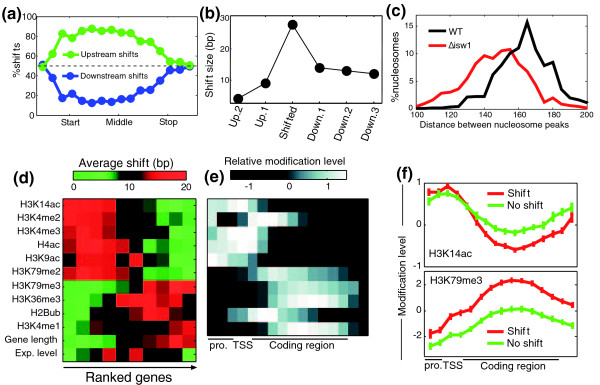
Patterns of Isw1-dependent shifts. (a) Percentage of Isw1-shifts that are upstream (green; nucleosomes are moved towards the 5' end in Δisw1) and those that are downstream (blue; nucleosomes are moved towards the 3' end in Δisw1) as a function of the relative position within genes (with respect to the start and stop codons). (b) Asymmetric effects at nucleosomes adjacent to those with shifts. For each gene with Isw1-shifts above 15 bp, we examined the extent of upstream shifts at the maximally shifted nucleosome and at its upstream and downstream adjacent nucleosomes, and the average shift sizes are shown. (c) Distribution of estimated distances between nucleosome centers of mid-coding nucleosomes (that are shifted upstream in Δisw1) and their flanking upstream nucleosomes, for wild-type (WT) and Δisw1 strains. (d) Average sizes of Isw1 upstream shifts at the +5 nucleosome for 10 subsets of genes ordered by various histone modifications, gene length, or mRNA expression levels. H3K79me2/3 and H2Bub were taken from Schulze et al. [55] and all other modifications from Pokholok et al. [56]. (e) Average levels of the histone modifications in (d), normalized to mean of zero and standard deviation one, throughout promoters and coding regions. (f) Average patterns of modifications for genes with Isw1 upstream shift of the +5 nucleosomes of at least 20 bp (red) and those without upstream shifts (green), shown for H3K14 acetylation (top) and H3K79 trimethylation (bottom).